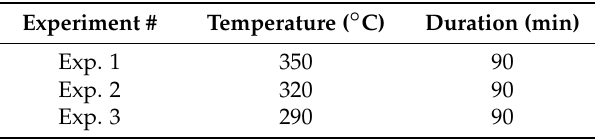
Figure 1. Graphical representation of the heat treatment conditions. Table 2. Austempering conditions of the samples.